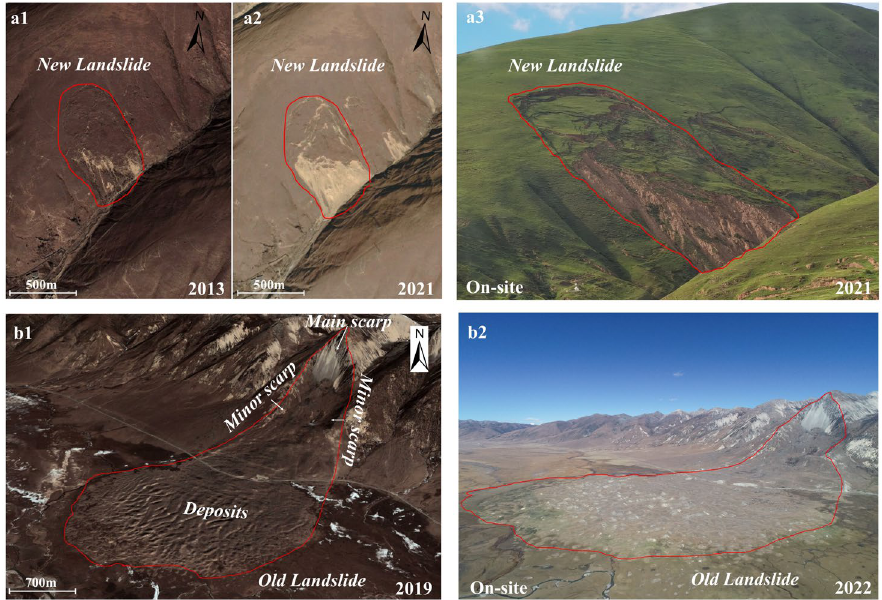
Figure 4. Satellite optical image interpretation and on-site survey of landslides along the STTC: a (30°58′16″ N, 101°09′19″ E) and b (30°12′09″ N, 99°56′10″ E) represent a new landslide and an old landslide, respectively, in which ( a1 , a2 , b1 ) are images obtained from Google Earth, ( a3 , b2 ) are images obtained from on-site survey.